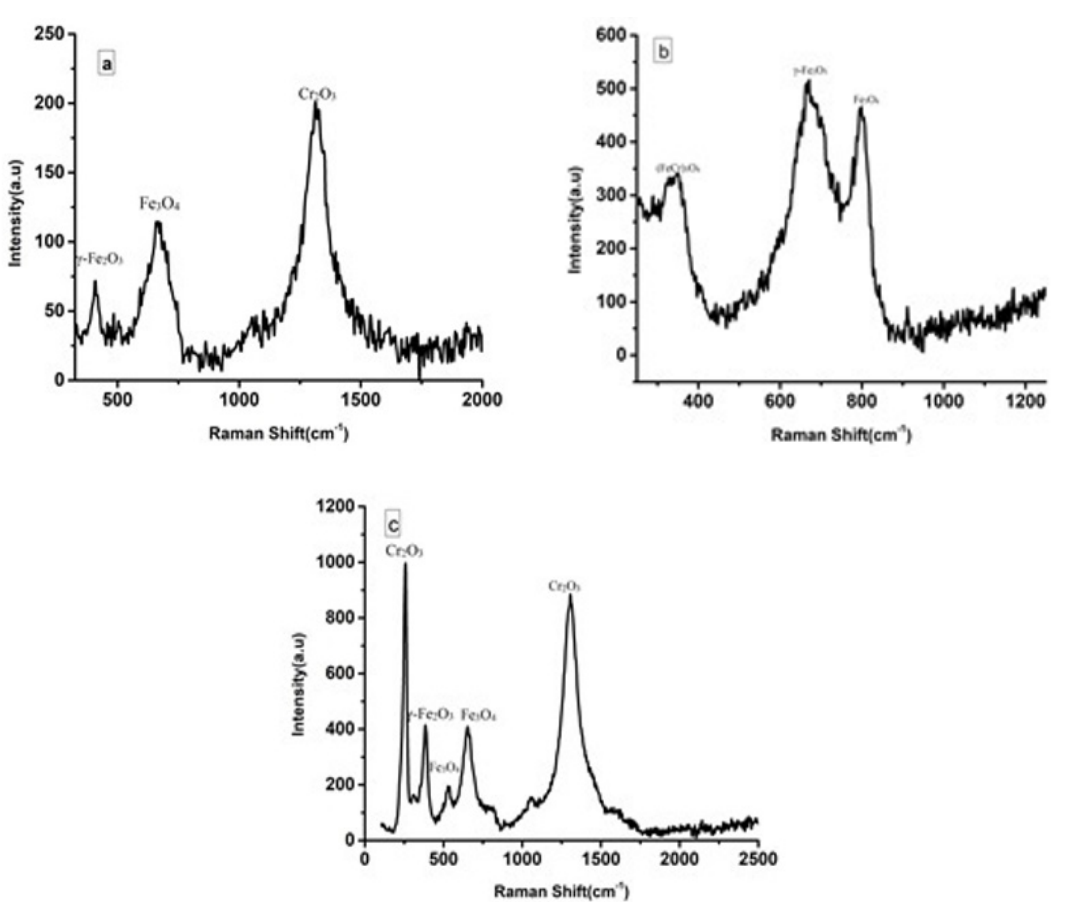
Figure 9. Raman spectroscopy images of 2205 duplex stainless-steel in the different solution with 3.5% NaCl at different pH ( a ) pH 2, ( b ) pH 7, and ( c ) pH 13.